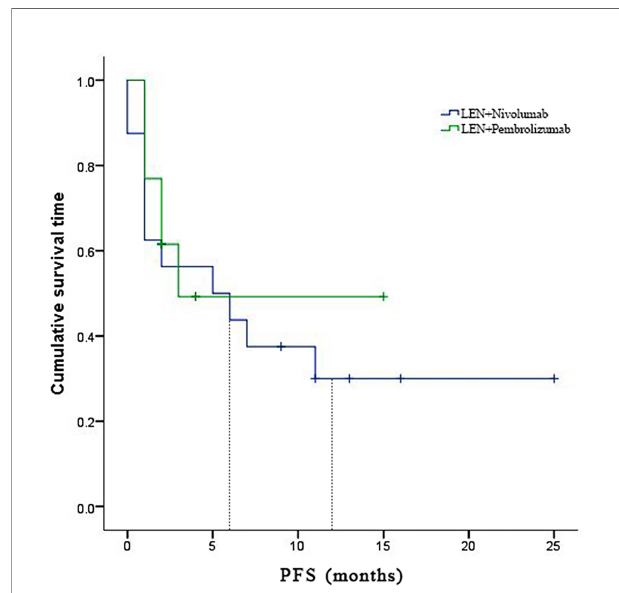
FIGURE 4 | Kaplan-Meier estimates of over survival with advanced hepatocellular carcinoma who were treated with lenvatinib plus Nivolumab and pembrolizumab, respectively.